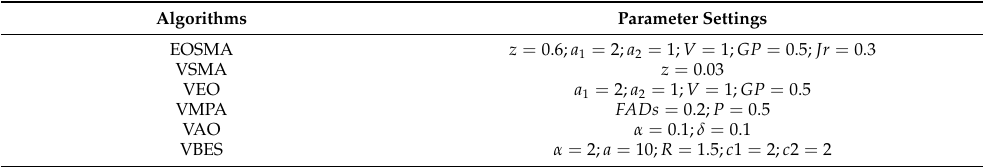
Table 4. Parameter settings of